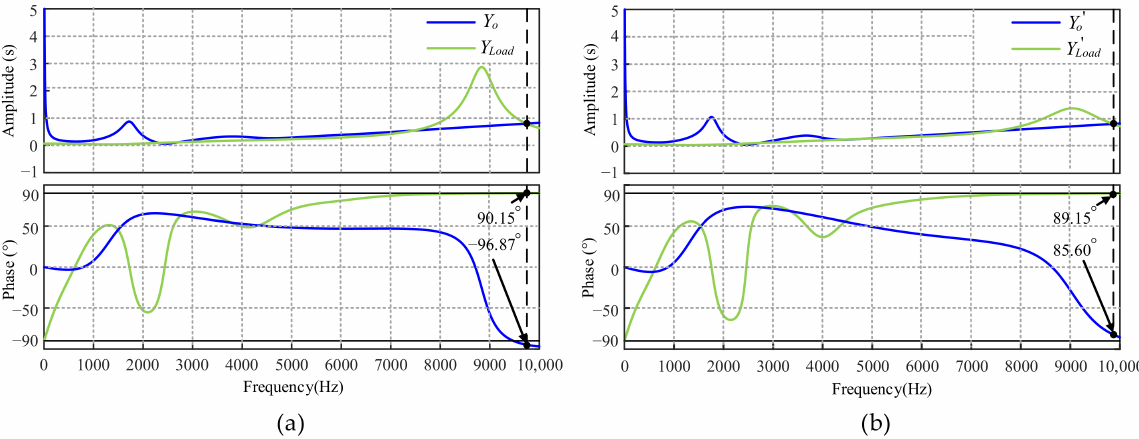
Figure 22. Frequency response of the inverter output admittance and the equivalent load admittance: ( a ) Before using the PLC; ( b ) after using the PLC.